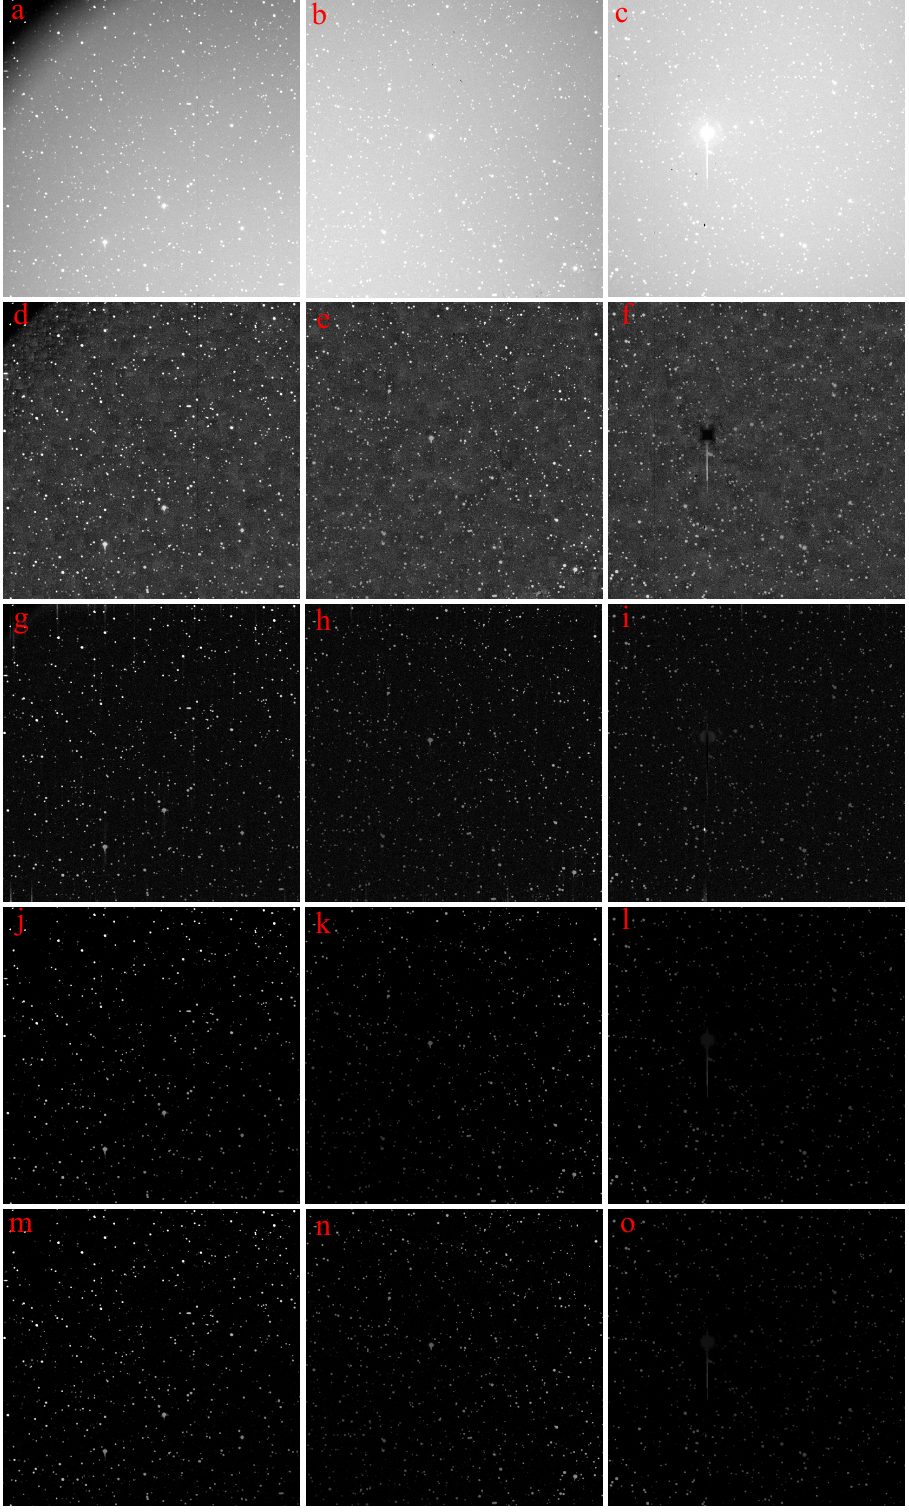
Figure 11. Nonuniform background elimination results. ( a – c ) Original real surveillance images; background elimination results of ( d – f ) THT; ( g – i ) MIF; ( j – l ) INTHT; and ( m – o ) IBSGM. The results of the residual image means and standard deviations obtained by different algorithms are shown in Table